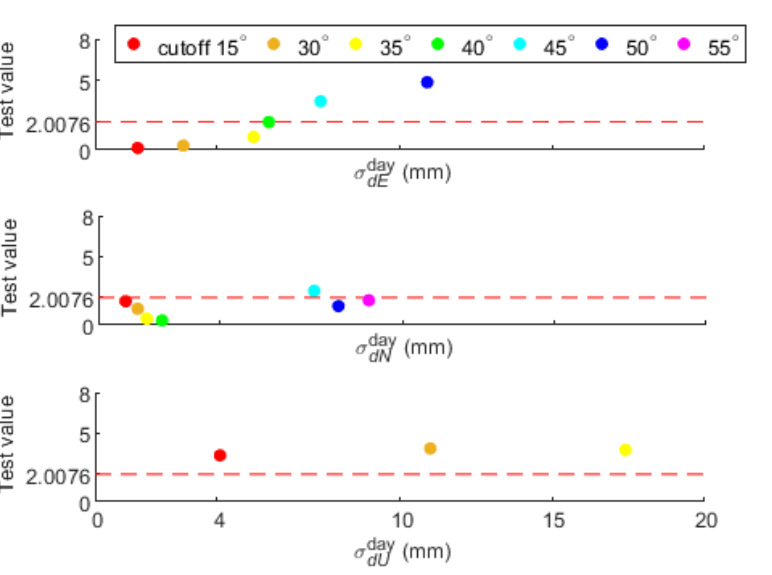
Figure 7. Test values of Student’s t -test for masking condition levels. The azimuth cutoff is from 90 ◦ to 270 ◦ . The GPS PPP is adopted during the process. The top , middle and bottom panels refer to the E, N and U directions, respectively.